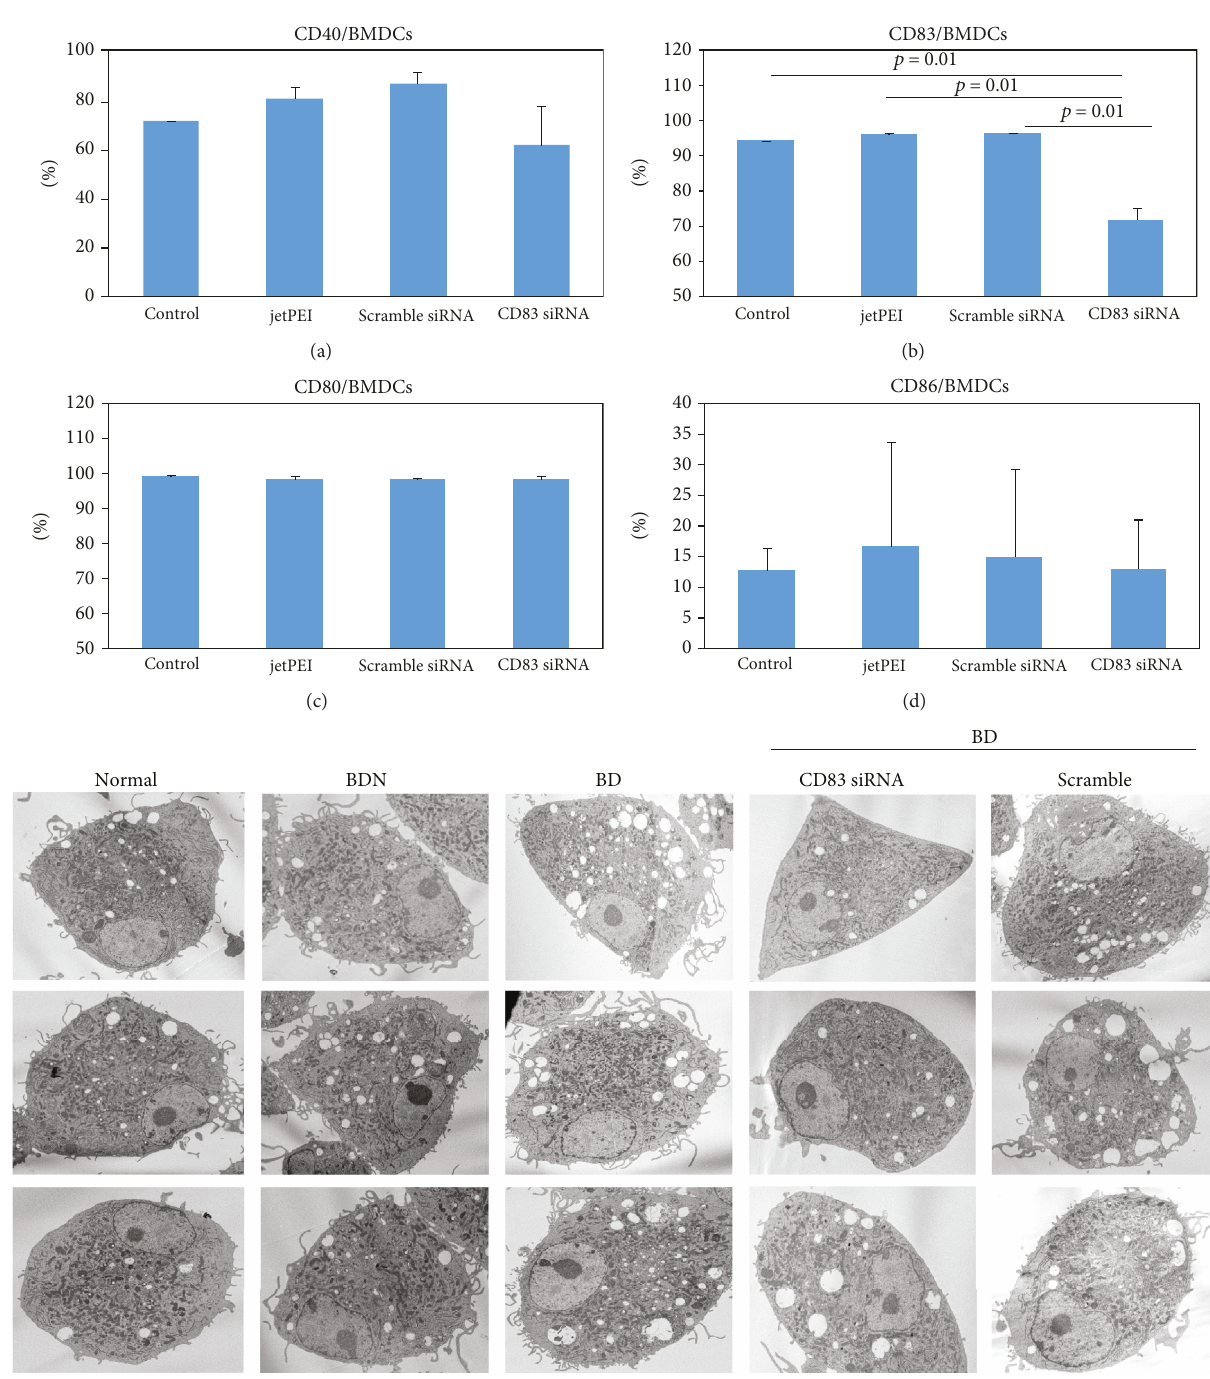
Figure 5: Bone marrow-derived DCs were cultured and treated with CD83 siRNA. (a – d) Frequencies of CD40-, CD83-, CD80-, and CD86- positive cells were measured by FACS analysis. (e) Morphological changes were observed under a transmission electron microscope. Data represent two independent